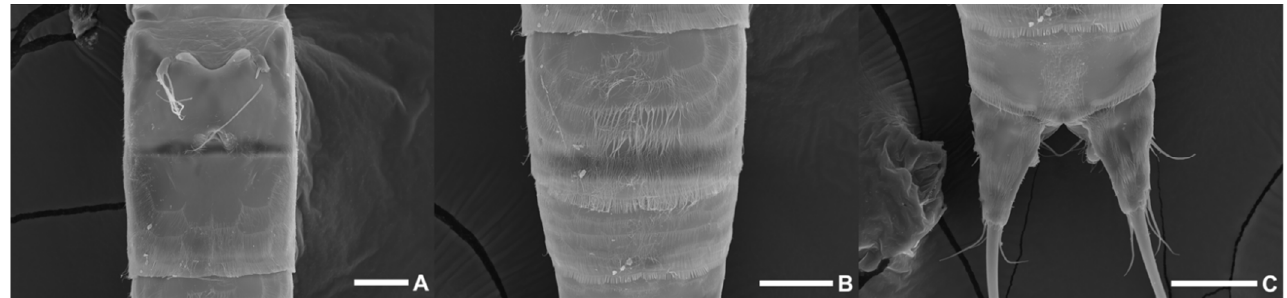
Figure 23. Scanning electron microscopy images of Phyllopodopsyllus similis sp. nov. female (paratype 4) in ventral view: ( A ) genital double-somite; ( B ) third and fourth urosomites; ( C ) anal somite and caudal rami. Scale bars: 30 µm.